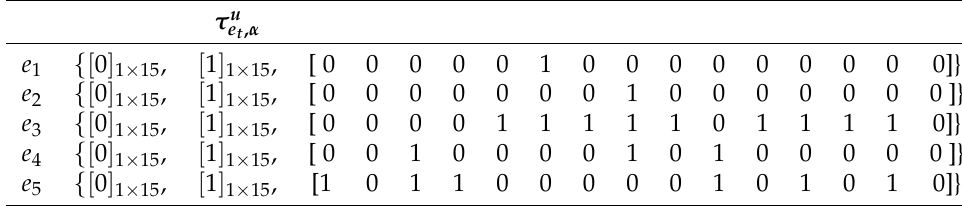
Table 9. α -Upper- e t topology; t = 1, . . .